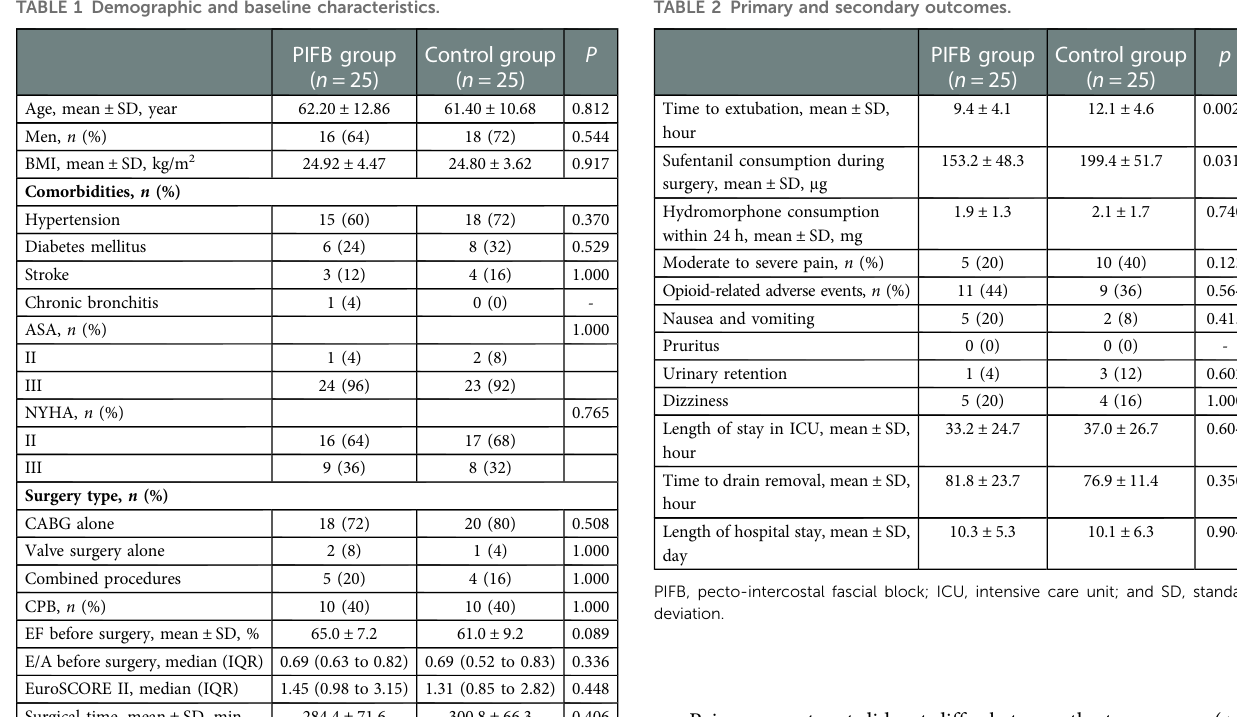
Pain scores at rest did not differ between the two groups ( p = 0.137; Figure 3 ). Pain scores upon coughing were lower in the PIFB group than in the control group ( p = 0.048). Post-hoc Sidak ’ s test showed a lower pain score upon coughing at 12 h in the PIFB group (1.45 ± 1.43 vs. 3.00 ± 1.71 in the control; p = 0.021), and no signi fi cant difference at either 24 or 48 h. The two groups did